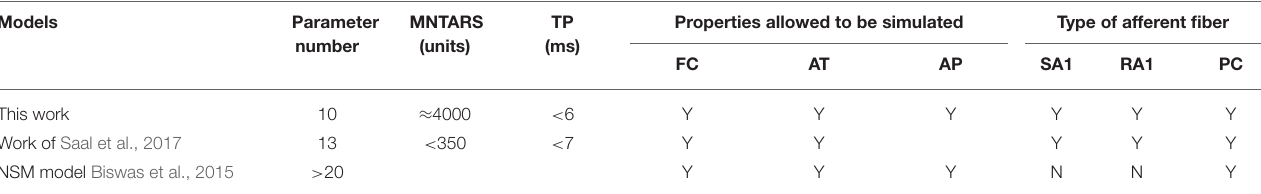
TABLE 2 | A comparison between the contributions of this work and the related works. Models Parameter